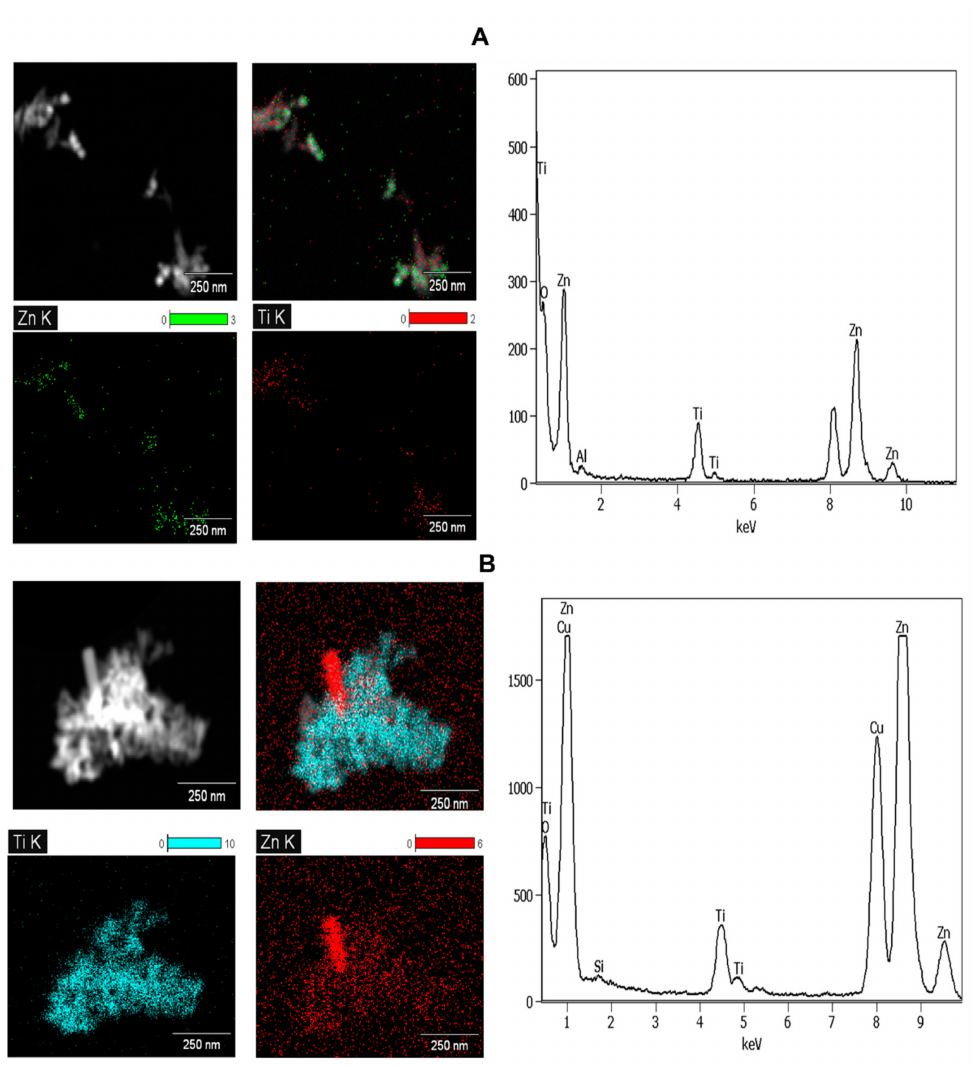
Figure 2. The energy-dispersive X-ray (EDX) elemental mapping for the identification of nTiO 2 and nZnO detected in SUN1 ( A ) and SUN5 ( B